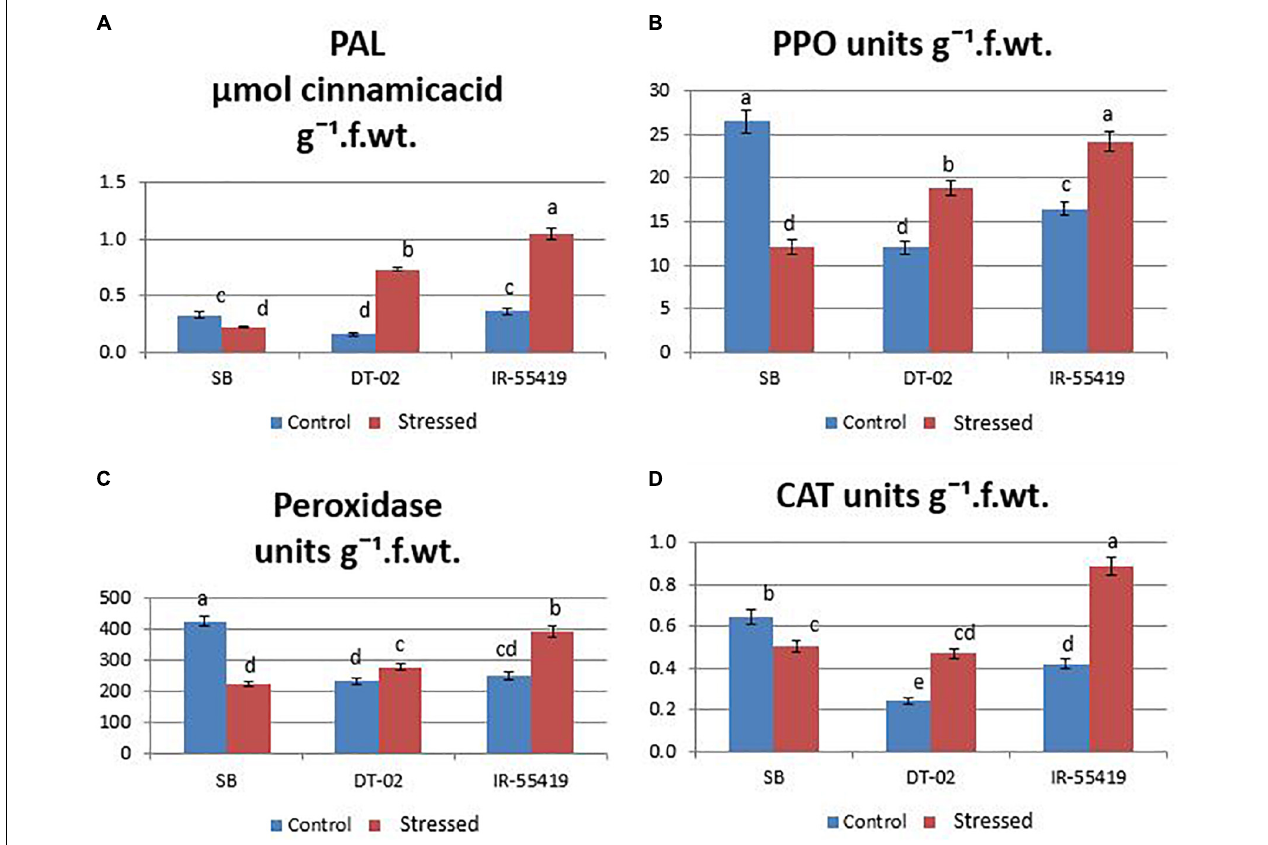
FIGURE 7 | Induction of defense-related enzymes. (A) Phenylalanine ammonia-lyase (PAL). (B) Polyphenol oxidase (PPO). (C) Peroxidase (POD). (D) Catalase (CAT) in rice plants of genotypes SB, IR-55419, and DT-02 under control-fully irrigated and stressed-water withholding for 15 days at 60 days after transplantation (DAT). Bars indicate the SD of three biological replicates and each replicate has three plants (ten leaves per plant). Data represented as means and means with the same letter differ non-significantly at p = 0.05 according to